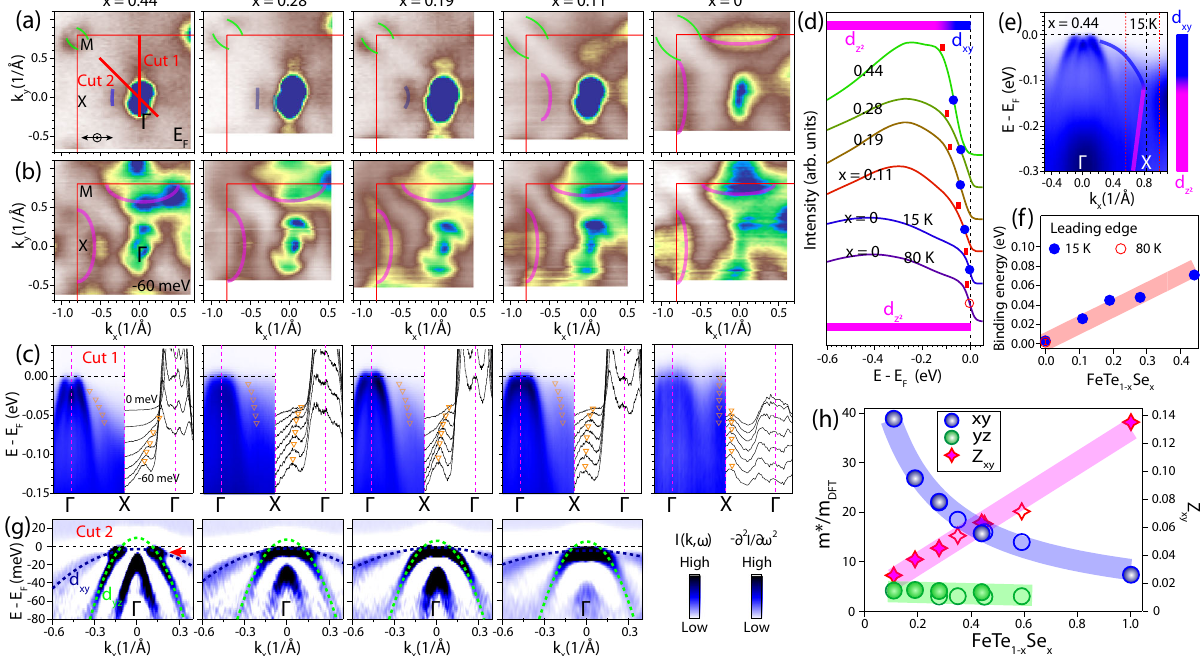
Fig. 3 Fermi surface evolution with Se ratio x . a Measured Fermi surfaces for different Se ratio x at 15 K except that for x = 0, which is measured at 80 K above its magnetic transition. b Simultaneously measured constant energy contours at − 60 meV showing no change. c Corresponding band dispersions and momentum distribution curves (MDCs) along the Γ -X- Γ direction. The markers are peaks fi tted from MDCs. The MDCs are for binding energies from 0 to 60 meV. d Integrated energy distribution curve (EDC) around X of FeTe 1 − x Se x with the integral range marked by the red dashed lines in ( e ). The energy positions where the integrated EDCs show a maximum curvature are marked by the red bars. The leading edge marked by the blue and red circles represents the energy position where the EDC intensity is half of where at the maximum curvature. e Band dispersion of FeTe 0.56 Se 0.44 at 15 K along the Γ - X- Γ direction. f Leading edge determined in ( d ) versus Se content of FeTe 1 − x Se x . g Band dispersions (second derivative) measured with 22 eV photons at 10 K along the Γ -M direction around the Brillouin zone center for different x . Parabolic fi ttings of the d yz and d xy hole bands are overlaid. The red arrow in left-most panel of ( g ) points at the hybridization of d yz and d xy orbitals. h Extracted band enhancement factor m * / m DFT for d yz and d xy plotted as a function of x represented by circles. The shaded lines are guides to the eyes. Diamond markers show the inverse of the d xy mass enhancement where the shaded pink line is a linear fi t. The empty markers are reproduced from Liu et al. 61